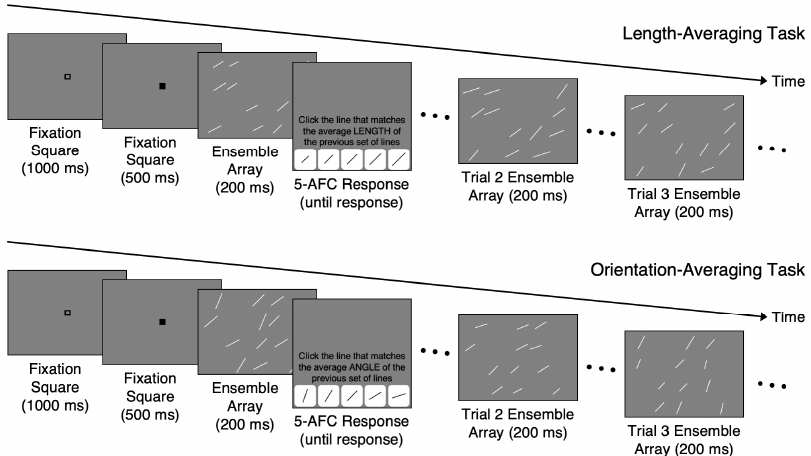
Figure 1. Example of the sequence of one trial and examples of ensemble arrays in the two subsequent trials in the length-averaging task ( top ) and in the orientation-averaging tasks ( bottom ). The size of fixation squares and the text in the response displays are not shown to exact scale for presentation purposes. The words in the response display read “Click the line that matches the average LENGTH/ORIENTATION of the previous set of lines.”